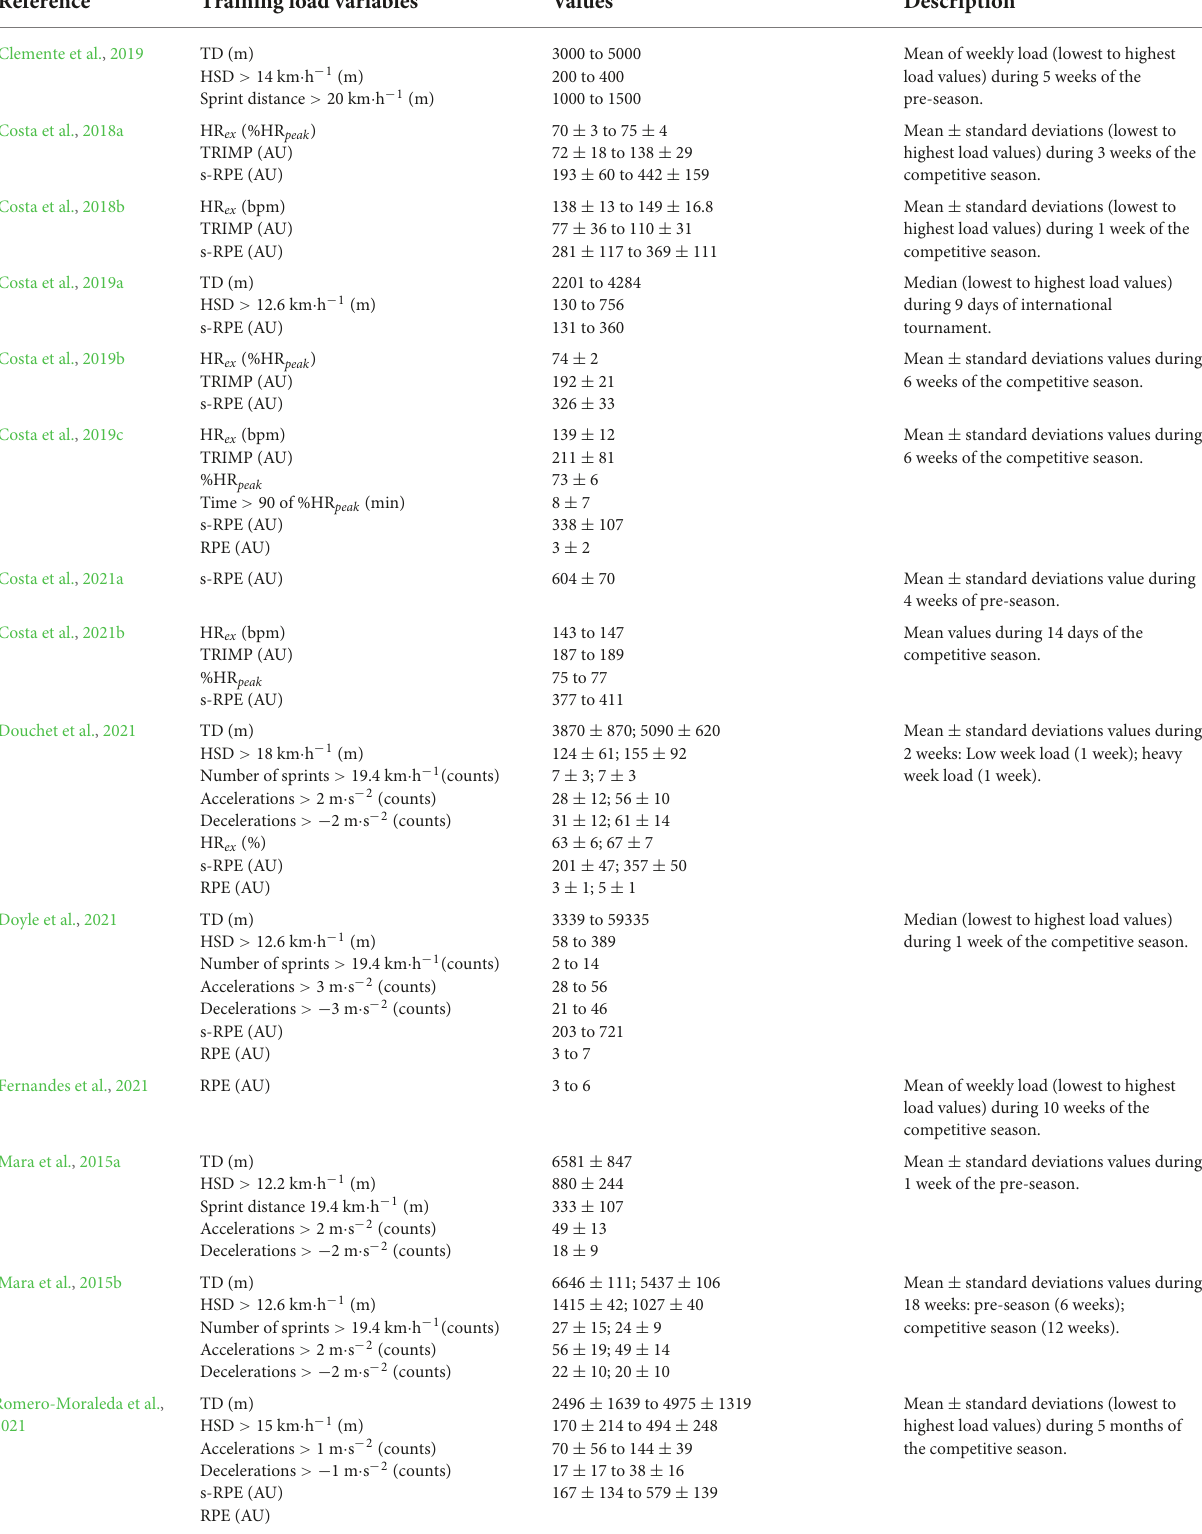
TABLE 2 Training load data during training sessions in highly trained and elite adult women soccer